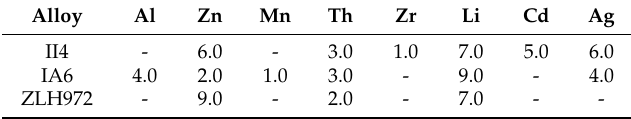
Table 5. Composition of best alloys selected in [21].